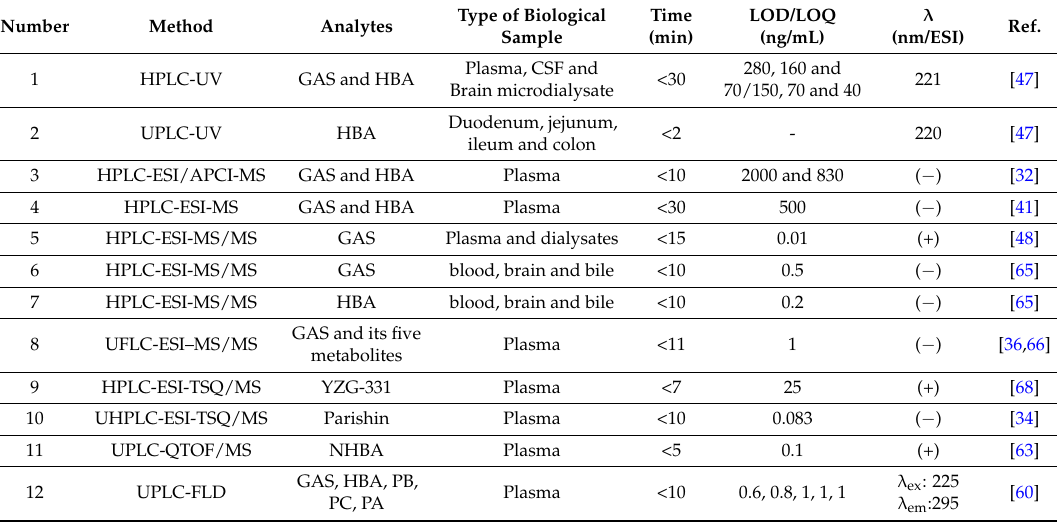
Table 1. The main method and relative parameters for the determination of constituents of G. elata